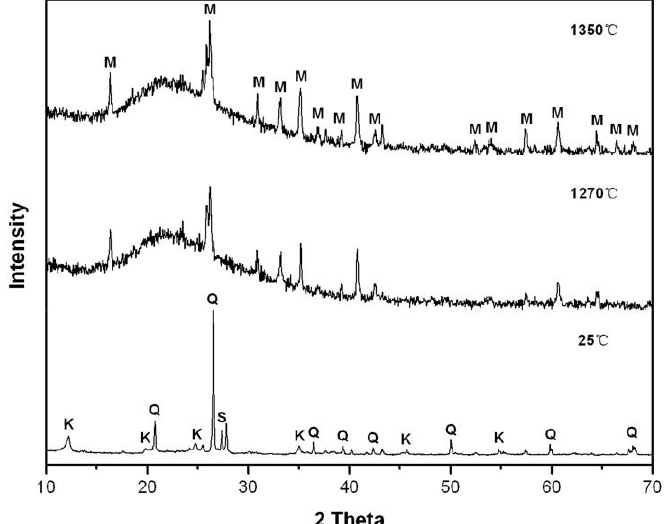
Figure 4. XRD patterns of M2 at 1270 °C and 1350 °C for 2 h; Q: quartz, M: mullite, K: kaolinite, S: